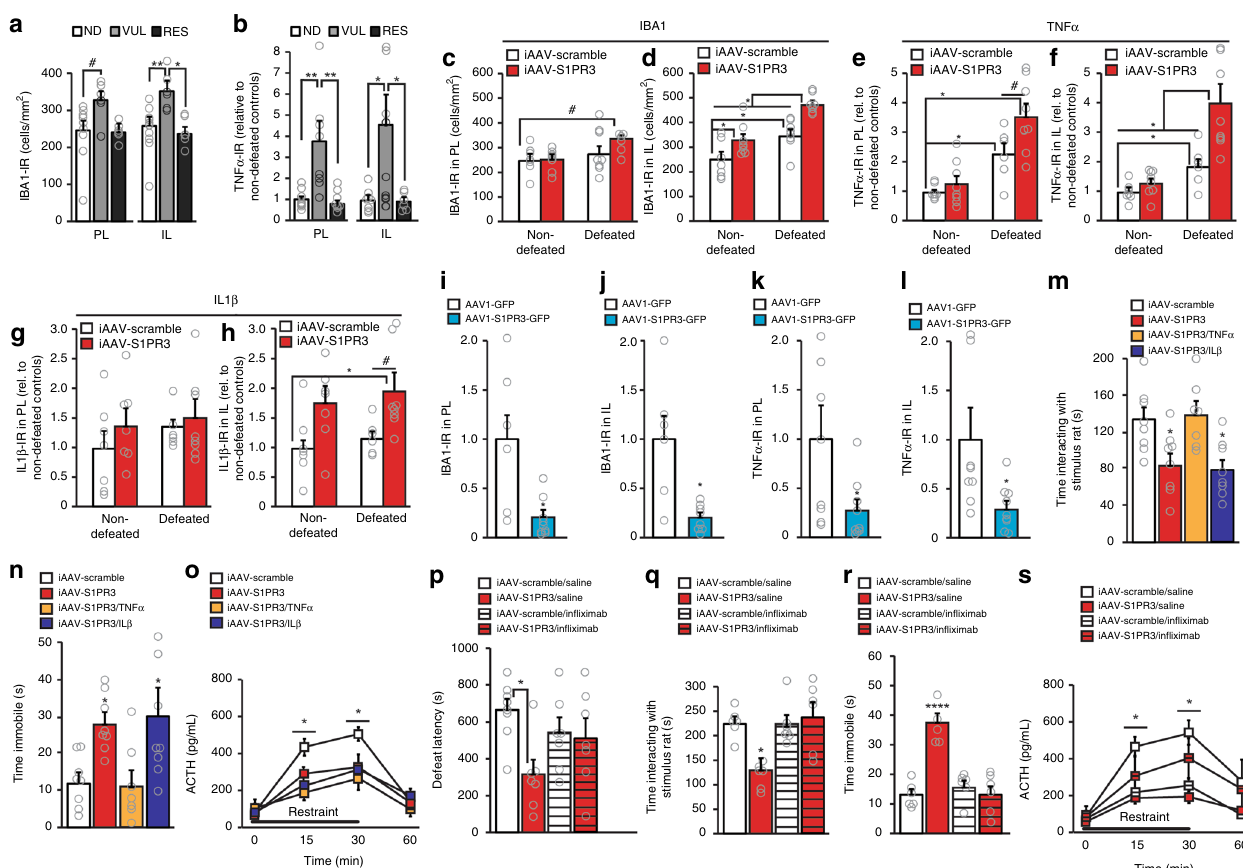
Fig. 3 S1PR3 promotes stress resilience by attenuating stress-induced in fl ammatory processes in the mPFC. a IBA1-IR cell density in PL and IL of ND ( n = 10), VUL ( n = 6), and RES ( n = 6) rats. b TNF α -IR (percent area above threshold) in PL and IL of ND ( n = 8), VUL ( n = 8), and RES ( n = 7) rats. IBA1-IR cell density in c PL and d IL of non-defeated and defeated iAAV-scramble and iAAV-S1PR3 rats (non-defeated iAAV-scramble n = 7, others n = 8/group). TNF α -IR in e PL and f IL. IL1 β -IR (percent area above threshold) in g PL and h IL. IBA1-IR (percent area above threshold) in i PL and j IL of AAV1-GFP ( n = 6) and AAV1-S1PR3 ( n = 9) rats. TNF α -IR (percent area above threshold) in k PL and l IL of AAV1-GFP ( n = 6) and AAV1-S1PR3 ( n = 9) rats. m iAAV-S1PR3 rats, but not iAAV-S1PR3/TNF α rats, displayed decreased time interacting with the stimulus rat compared to iAAV-scramble rats (iAAV-S1PR3/TNF α n = 7, others n = 8/group). n iAAV-S1PR3 rats, but not iAAV-S1PR3/TNF α rats, displayed increased time immobile in the test phase of the Porsolt Forced Swim Test compared to iAAV-scramble rats (iAAV-S1PR3/TNF α n = 7, others n = 8/group). o Plasma ACTH concentrations in response to restraint (iAAV-S1PR3/TNF α n = 7, others n = 8/group). p Mean latency to defeat was reduced in saline-treated, but not in fl iximab-treated, iAAV-S1PR3 rats compared to saline-treated iAAV-scramble rats ( n = 7/group). q Time interacting with the stimulus rat was reduced in saline-treated, but not in fl iximab- treated, iAAV-S1PR3 rats compared to saline-treated iAAV-scramble rats (iAAV-scramble/in fl iximab n = 7, others n = 6/group). r Time immobile in the Porsolt Forced Swim Test was increased in saline-treated, but not in fl iximab-treated, iAAV-S1PR3 rats compared to saline-treated iAAV-scramble rats (iAAV-S1PR3/saline n = 5, others n = 6/group). s Plasma ACTH responses to restraint were reduced in iAAV-S1PR3/saline and iAAV-scramble/in fl iximab rats compared to controls at 15 and 30 min timepoints. Bars represent mean + SEM. * p < 0.05, *** p < 0.001, **** p < 0.0001, # p < 0.07. Horizontal bars represent post-hoc differences. Statistical tests: a , b Tukey/one-way ANOVA; c – h , p – r Bonferonni/two-way ANOVA; i – l Student ’ s t -test; m , n Holm- Sidak ’ s/one-way ANOVA; o , s Bonferonni/repeated measures two-way ANOVA). For m and n , asterisk (*) represents difference from iAAV-scramble rats. For p and r , * and **** indicate differences from all other